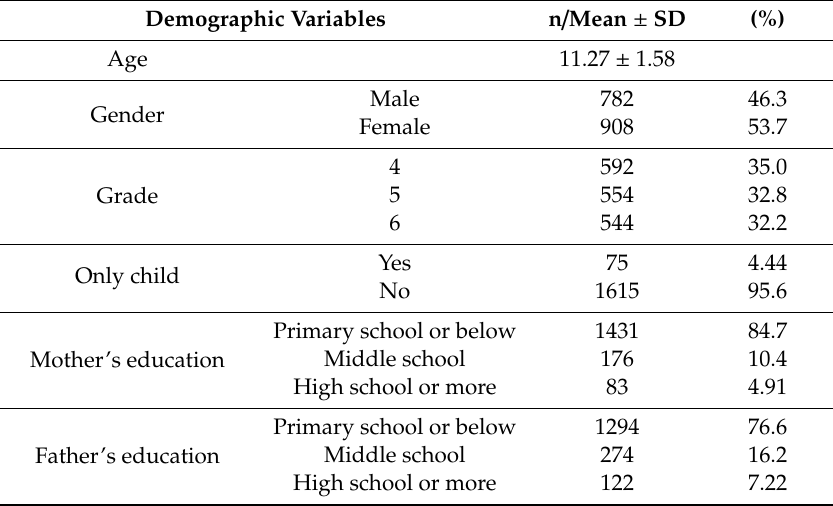
Table 1. Demographic characteristics of the study population (N = 1690).